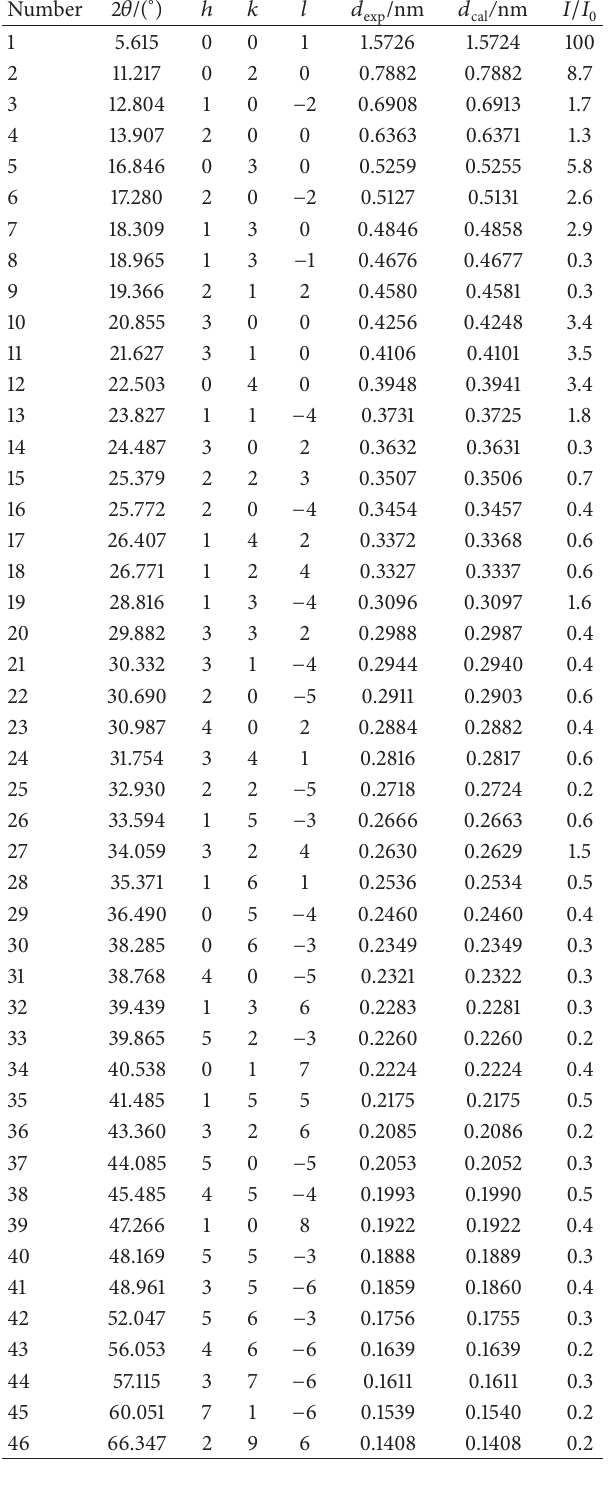
Table 2: Experimental data and calculated results for X-ray powder diffraction pattern of the complex Mn(HMHA) 2 .